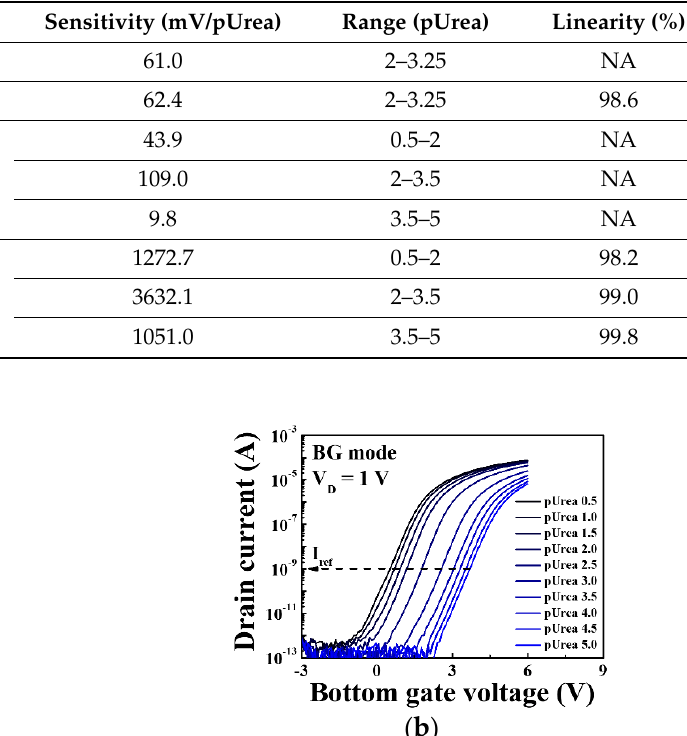
ISFET-based urea sensors.